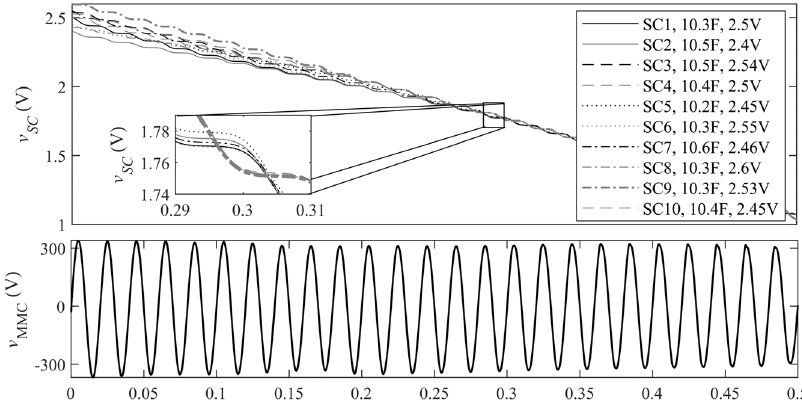
Figure 12. Balancing process (10 kW, discharge mode) in the whole voltage range.